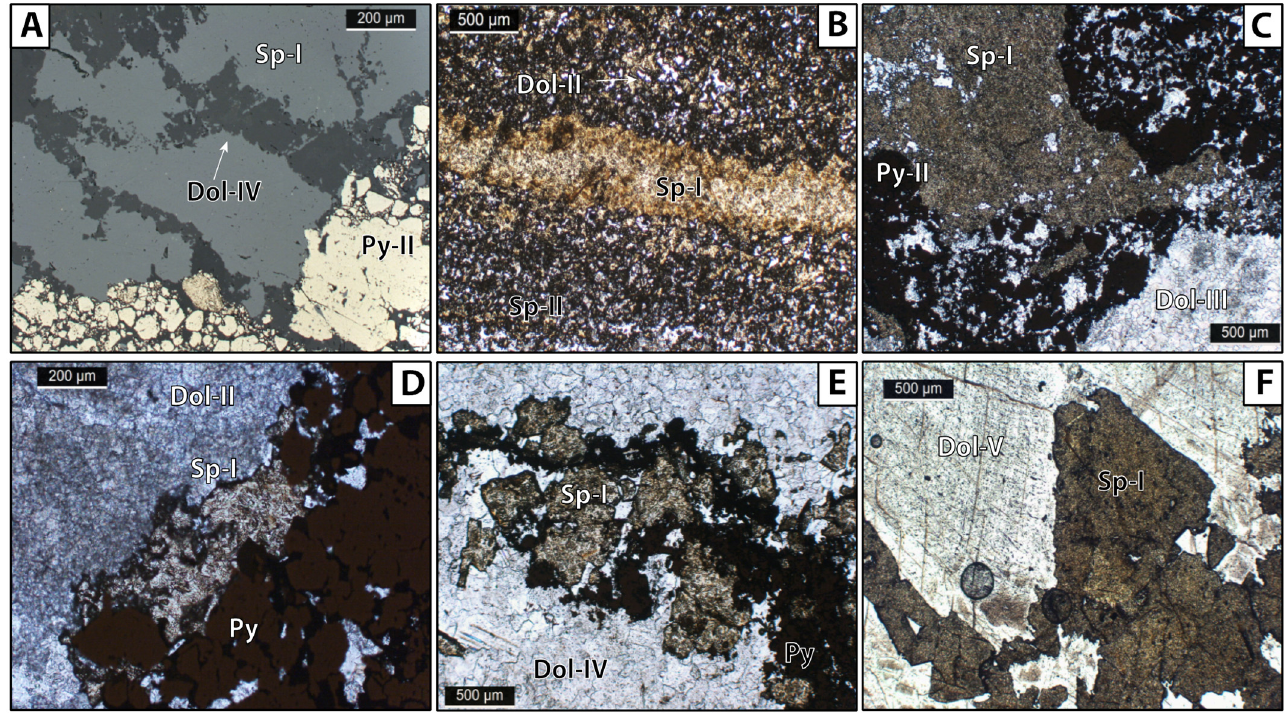
Figure 6. Examples of mineralized samples displaying textural and mineralogical features in the Morro Agudo district from the earliest stages of mineralization. Samples A and B are from the N orebody, C is from the Sucuri occurrence, D is from the Morro do Capão occurrence, and E,F are from the Bento Carmelo occurrence. (PPL = plane polarized light; RL = reflected light). ( A ) Coarse sphalerite (Sp-I) and dolomite (Dol-IV) associated with hydrothermal pyrite (Py-II) overgrowing earlier diagenetic pyrite (Sample ID = MA580-980–03; RL). ( B ) Sphalerite vein (Sp-I) and dolomite (Dol-II) being partially replaced by fine-grained disseminated sphalerite (Sp-II) (Sample ID= MA- N350–4; PPL). ( C ) Coarse vein of sphalerite (Sp-I) and pyrite (Py-II) cross-cutting hydrothermal dolomite (Dol-III) (Sample ID = S-PBC-45–31; PPL). ( D ) Yellow sphalerite filling space between coarse pyrite vein and sparitic dolomite (Dol-II) (Sample ID = MC-PMC-05–17; PPL). ( E ) Sphalerite replacing a pyrite-bearing stylolite (Sample ID = BC-MAN-34–04; PPL). ( F ) Coarse-grained sphalerite